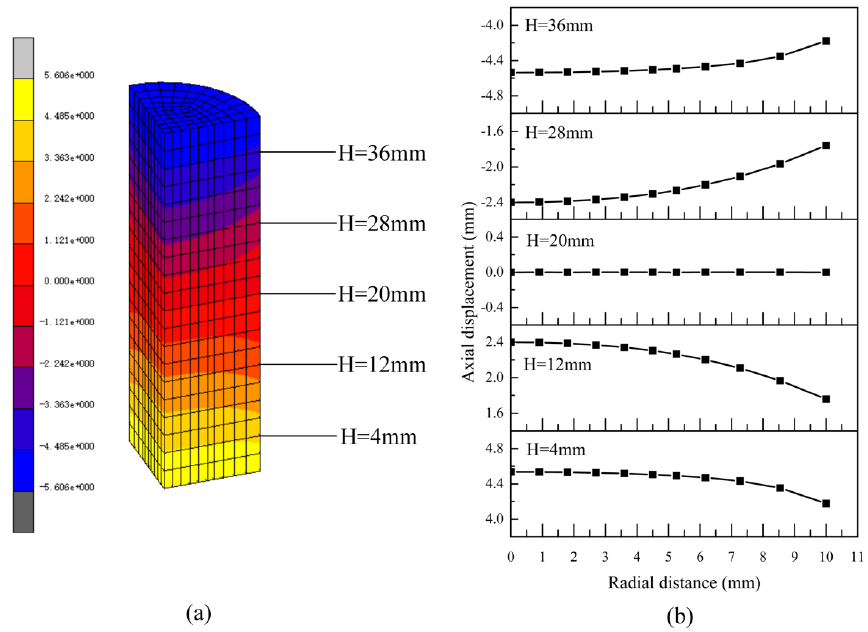
Figure 20. Axial displacement distribution in powder compact at μ = 0.2 in ( a ) displacement contours and ( b ) displacement at different compact heights.